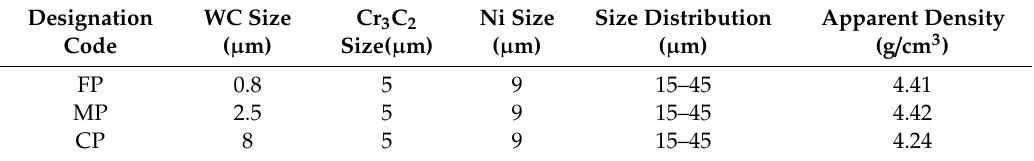
Table 1. Powder designation code, characteristics, and average size of the raw ceramic and Ni